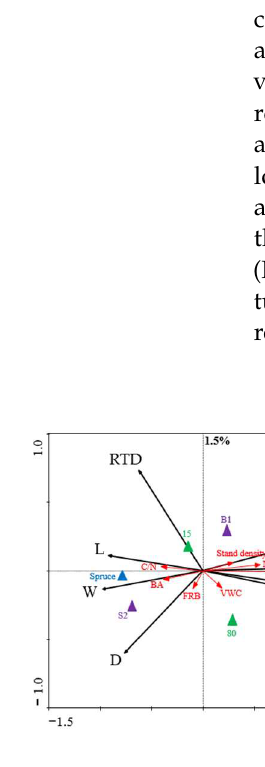
Figure 3. The ordination biplot based on redundancy analysis (RDA, manual forward selection) of absorptive root morphological traits, including D—diameter (mm), L—length (mm), W—dry weight (mg), BI L —branching intensity per length (cm − 1 ), BI w —branching intensity per mass (mg − 1 ), SRA—specific root area (m 2 kg − 1 ), SRL—specific root length (m g − 1 ), and RTD—root tissue density (kg m − 3 ) (black arrows) for both studied tree species, Downy birch and Norway spruce ( A ), and separately for birch ( B ) and spruce ( C ). In all figures, absorptive root morphological traits were shown in relation to the tree species (blue triangles), forest stands (purple triangles), sampling plots (green triangles), and studied stand and soil characteristics (red arrows). The relative eigenvalues of axis 1 and axis 2 were 63.2% and 1.5%, respectively, and in total, the model described 65.4% of the variation in absorptive root traits (Figure 3A, p < 0.05).